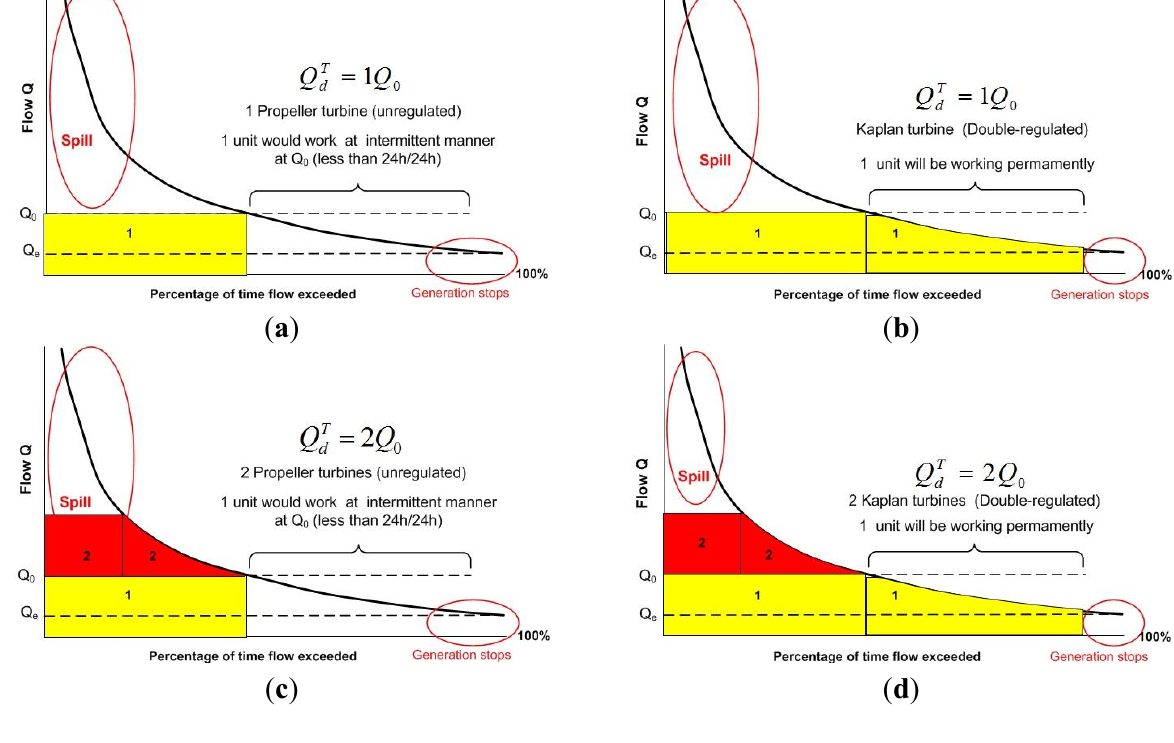
Figure 12. ( a ) 1 Propeller turbine, Q T = 1 Q 0 ; ( b ) 1 Kaplan turbine, Q T = 1 Q 0 ; d d ( c ) Two propeller turbines, Q T = 2 Q 0 ; ( d ) Two Kaplan turbines, Q T = 2 Q 0 . Hypothetical d d FDC and its coverage by the propeller and Kaplan turbines (from 1 to 2 units). Q —daily flow; Q T —design discharge of turbines; Q 0 —mean annual flow; Q e —environmental (instream) d flow. Red and yellow indicate turbines working